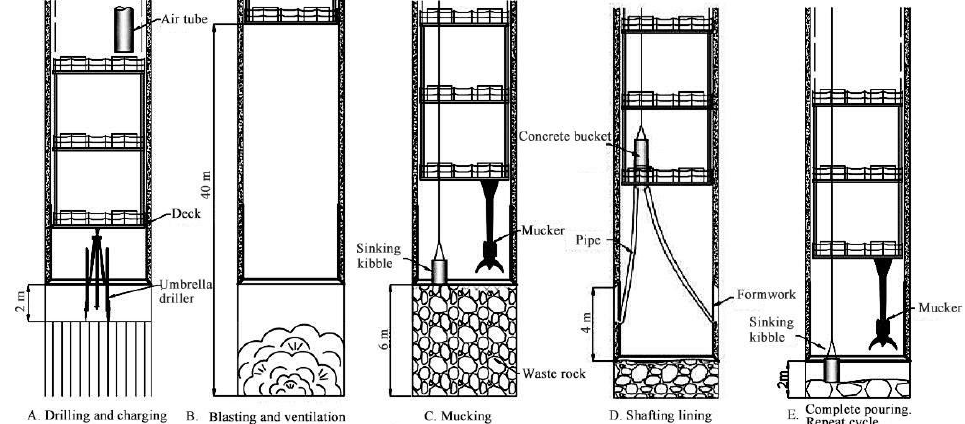
Figure 1. Sequence of operations while sinking through normal ground conditions.